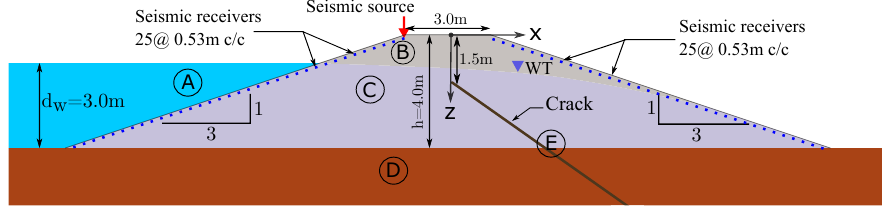
Figure 8. A physical model of dam including a crack and soil-water interface to perform forward seismic wave simulation. The material parameters are as given in Table 3 and 55 seismic receivers are located along the dam surface with spacing of 0.53